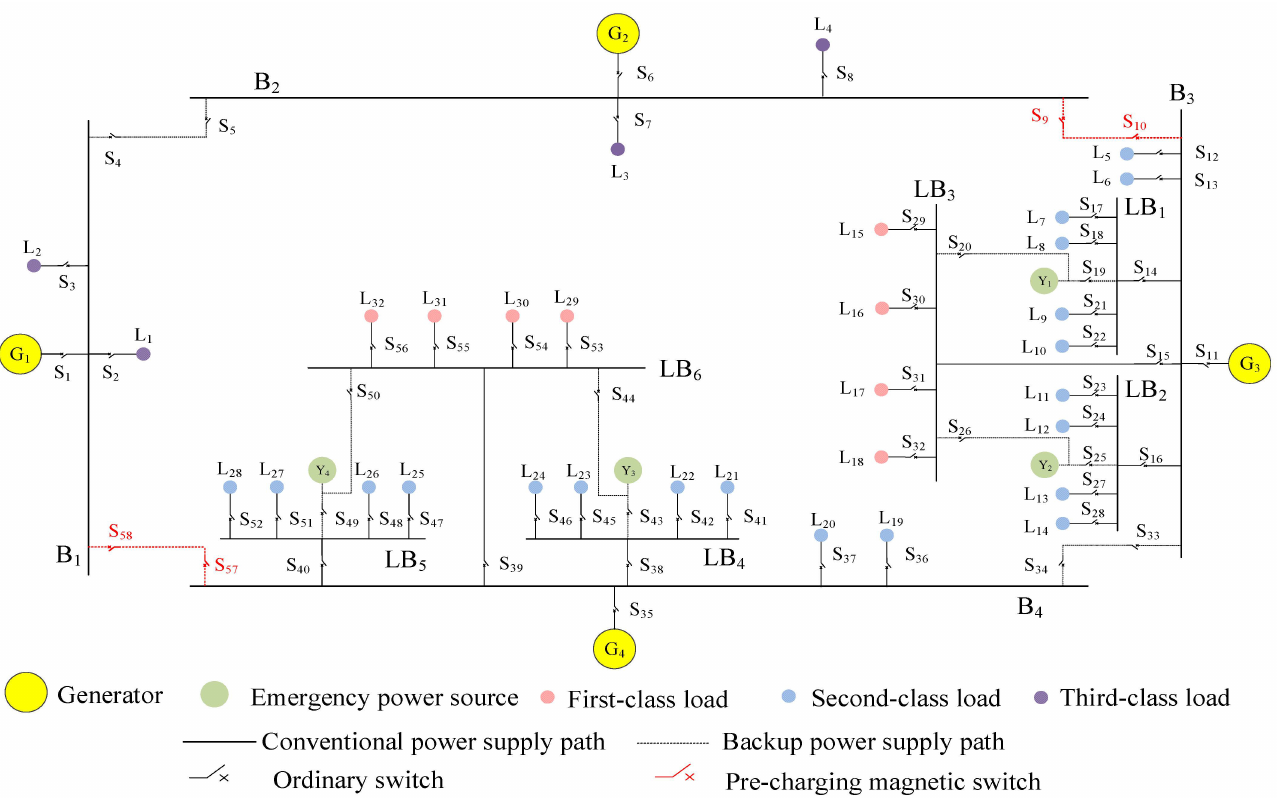
Figure 2. Topological wiring diagram of the power system network for the floating nuclear power